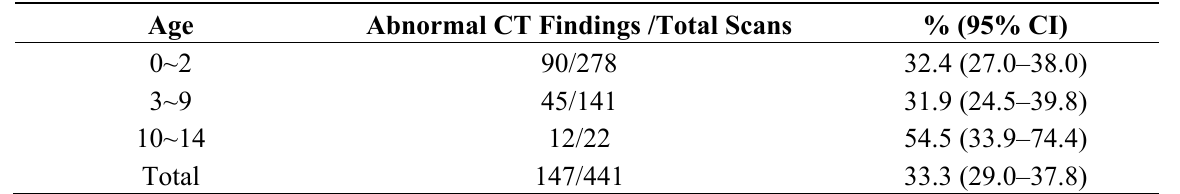
Table 3. Percentage of abnormal CT findings among children who had a CT scan by